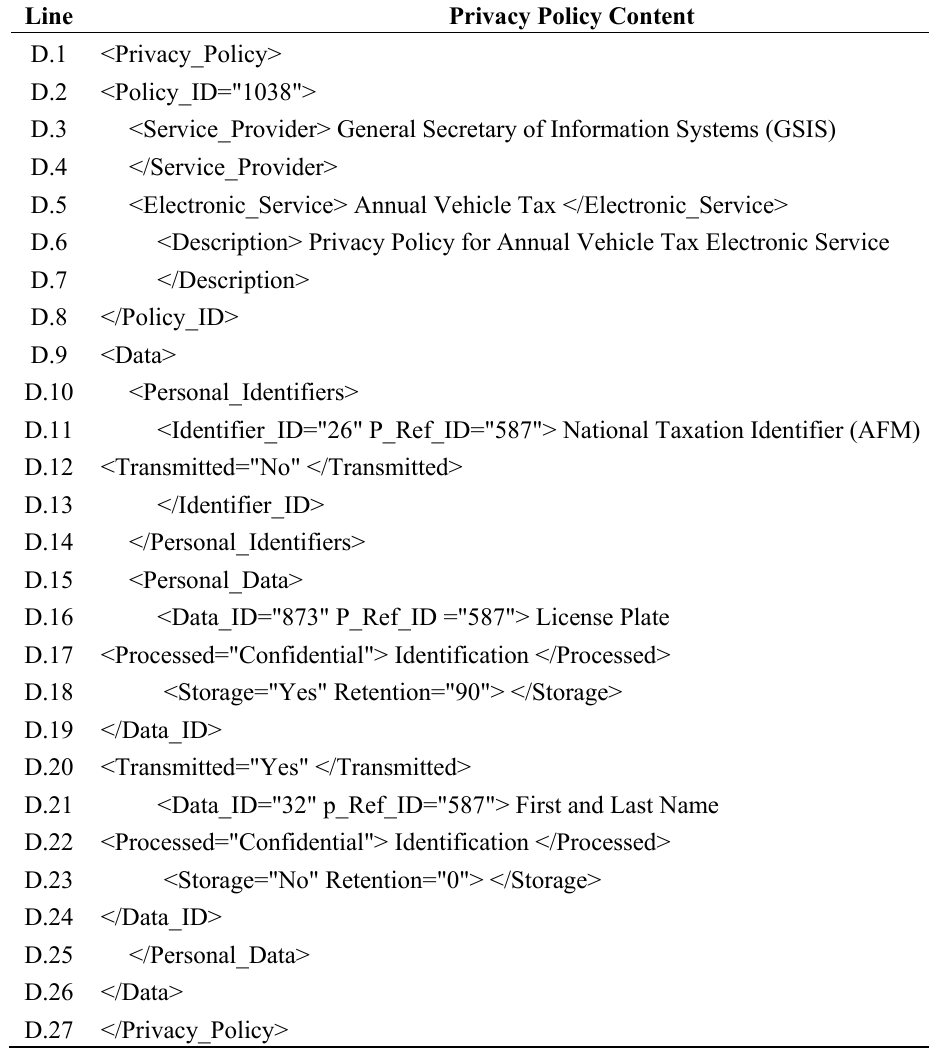
Table 4. AVT Service Privacy Policy.